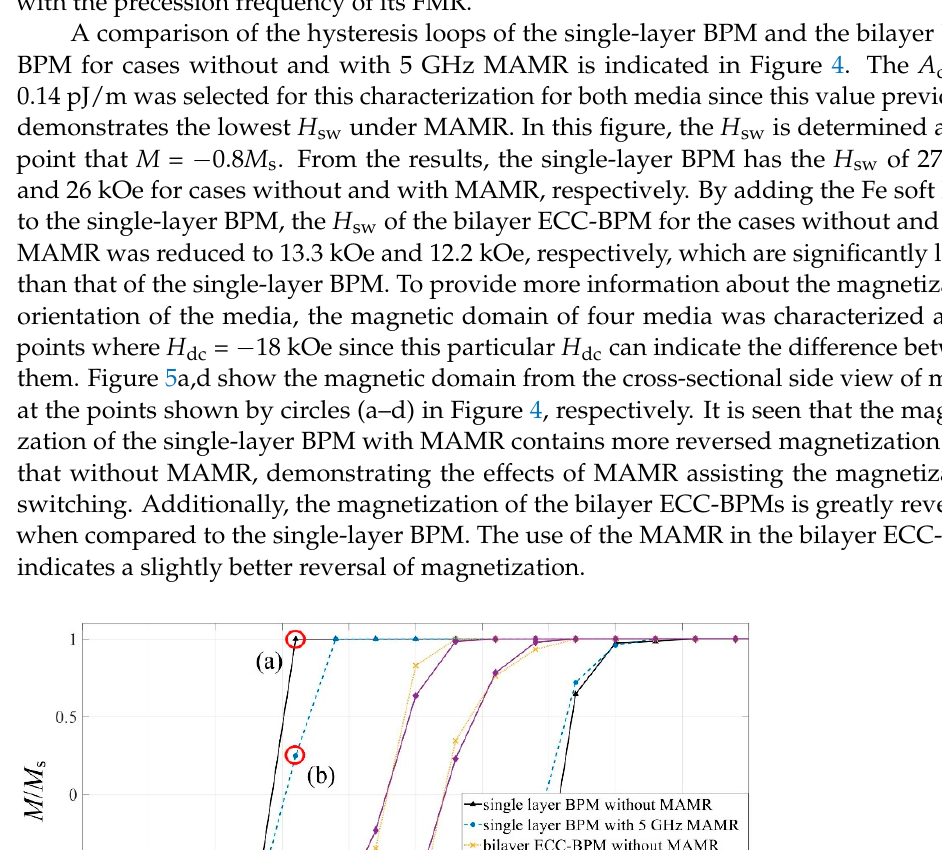
Figure 3. H sw of the bilayer ECC - BPM with and without HAMR as a function of A dot .